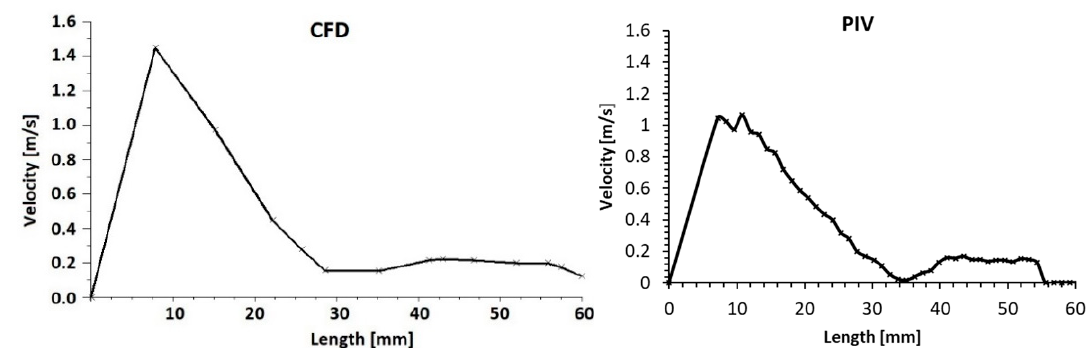
Figure 12. Velocity graphs in cross-section behind the first baffle for setting 2.